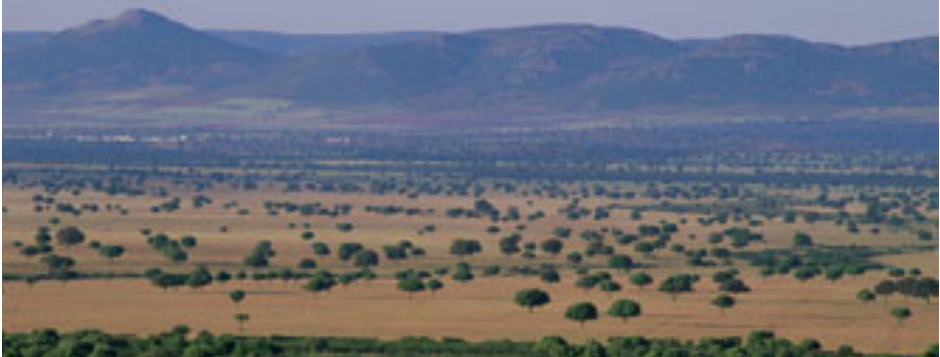
Figure 1. Landscape of the Caba˜neros National